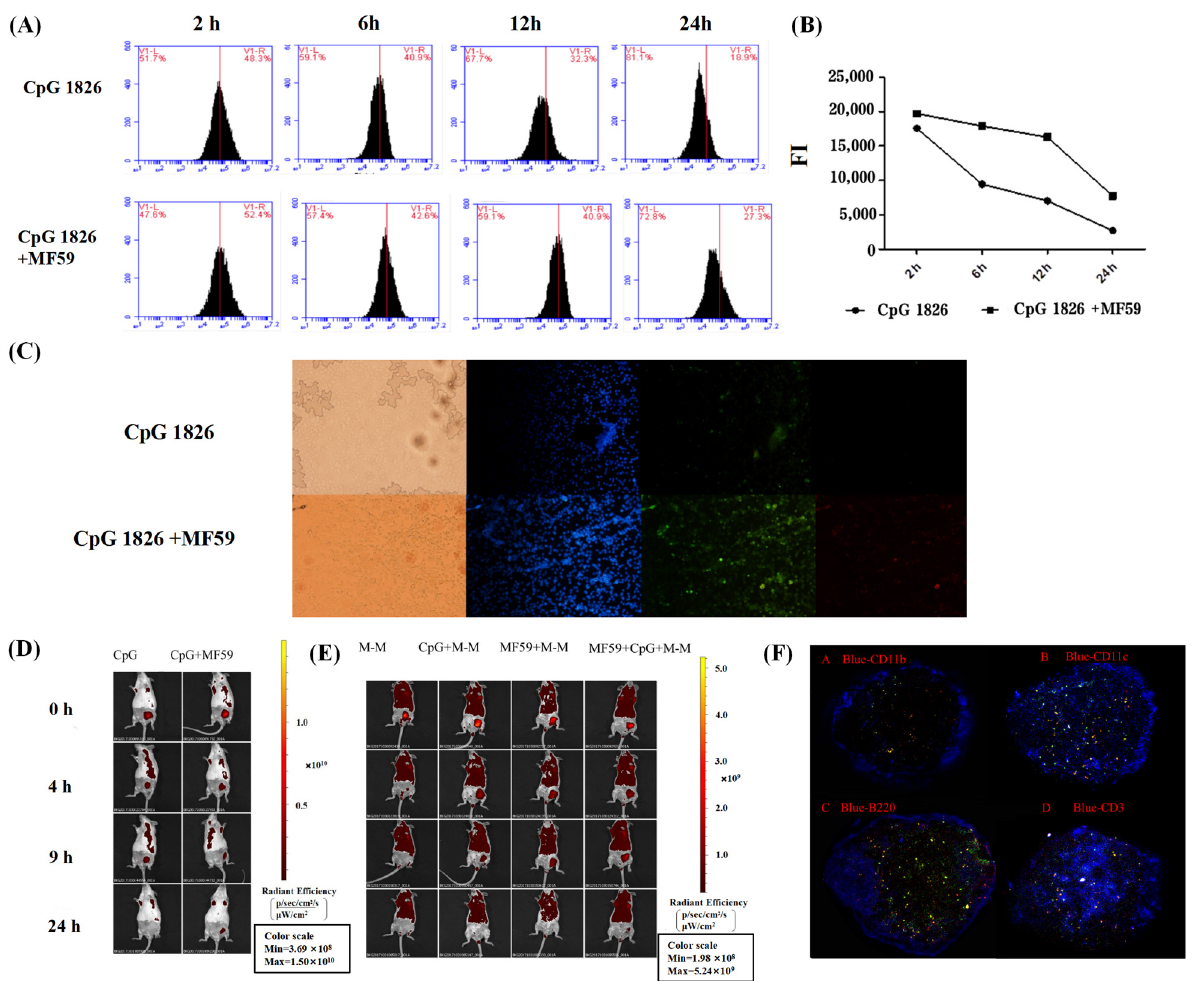
Figure 5. MF59/CpG 1826 promotes BMDC uptake, retention, and local retention in vivo and in vitro. ( A – C ) In vitro study. ( A ) Fluorescence intensity of CpG 1826-FITC-positive cells. Total fluorescence intensity (FI) = % of positive cells × mean fluorescence intensity. ( B ) MF59 promotes the uptake of CpG 1826 by BMDCs, as shown by fluorescence microscopy. Blue represents DAPI-stained nuclei, red represents Dil-labeled MF59, and green represents FITC-labeled CpG 1826. ( C – E ) In vivo study. ( C ) Effect of MF59 on CpG 1826 retention in mouse lymph nodes. Mice were immunized with FITC-labeled CpG or FITC-labeled CpG/MF59 and photographed under a small animal live imager at 0, 4, 9, and 24 h. ( D ) Effects of different adjuvants on the retention of M/M in mouse lymph nodes. Mice were immunized with FITC-labeled M-M, FITC-labeled M-M/CpG 1826, FITC-labeled M-M/MF59, or ( E ) FITC-labeled M-M/CpG1826/MF59 and photographed under a small animal live imager at 0, 4, 9, and 24 h. ( F ) Subcellular localization of CpG 1826 and MF59. Mice were immunized with FITC-labeled CpG 1826/Dil-labeled MF59. After 24 h of immunization, lymph nodes were taken to prepare frozen sections, and four slices were cut in the same site for immuno- fluorescence observation. Frozen sections of lymph nodes were stained with Violet-CD11b, Violet-